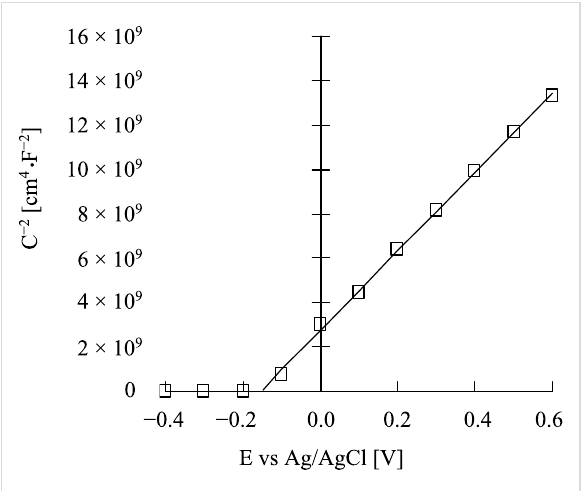
Figure 4: Mott–Schottky plot of a nanoporous TiO 2 thin film coated on FTO in contact with a 10% aqueous methanol solution (+ 0.1 M Na 2 SO 4 ) under irradiation. Measured with 100 Hz frequency and AC amplitude = 10 mV.